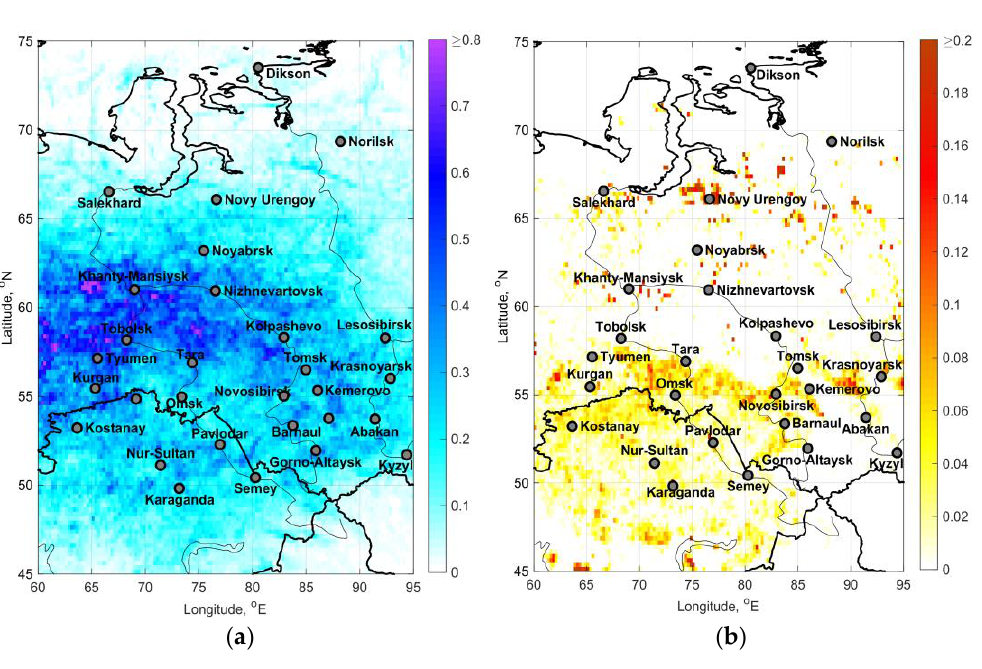
Figure 1. The spatial distribution over Western Siberia for the warm season from 2016 to 2021: lightning discharge density (flashes per km 2 per year) ( a ) and hotspots density (hotspots number per km 2 per year) ( b